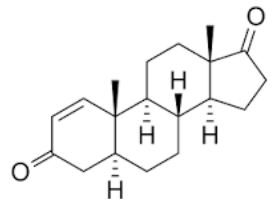
Figure 1. Chemical structure of 1-androstenedione. Formula: C 19 H 26 O 2 .